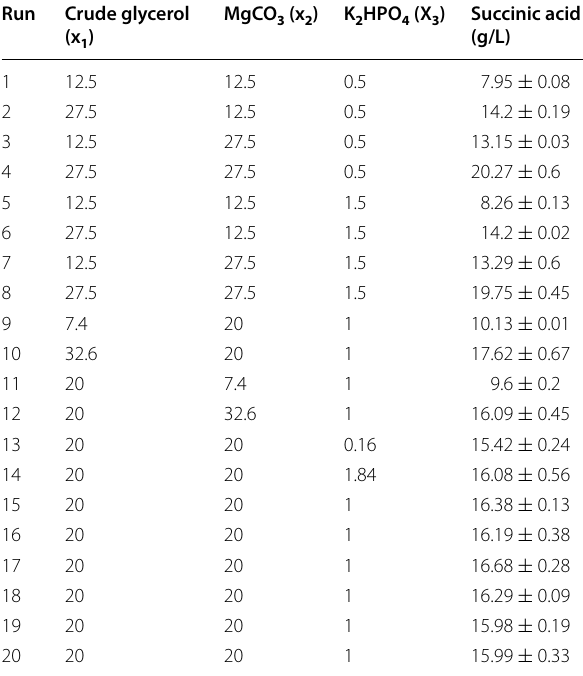
Table 4 Central composite design matrix of the independ- ent variables with the corresponding experimental values of succinic acid concentration Run Crude glycerol (x 1